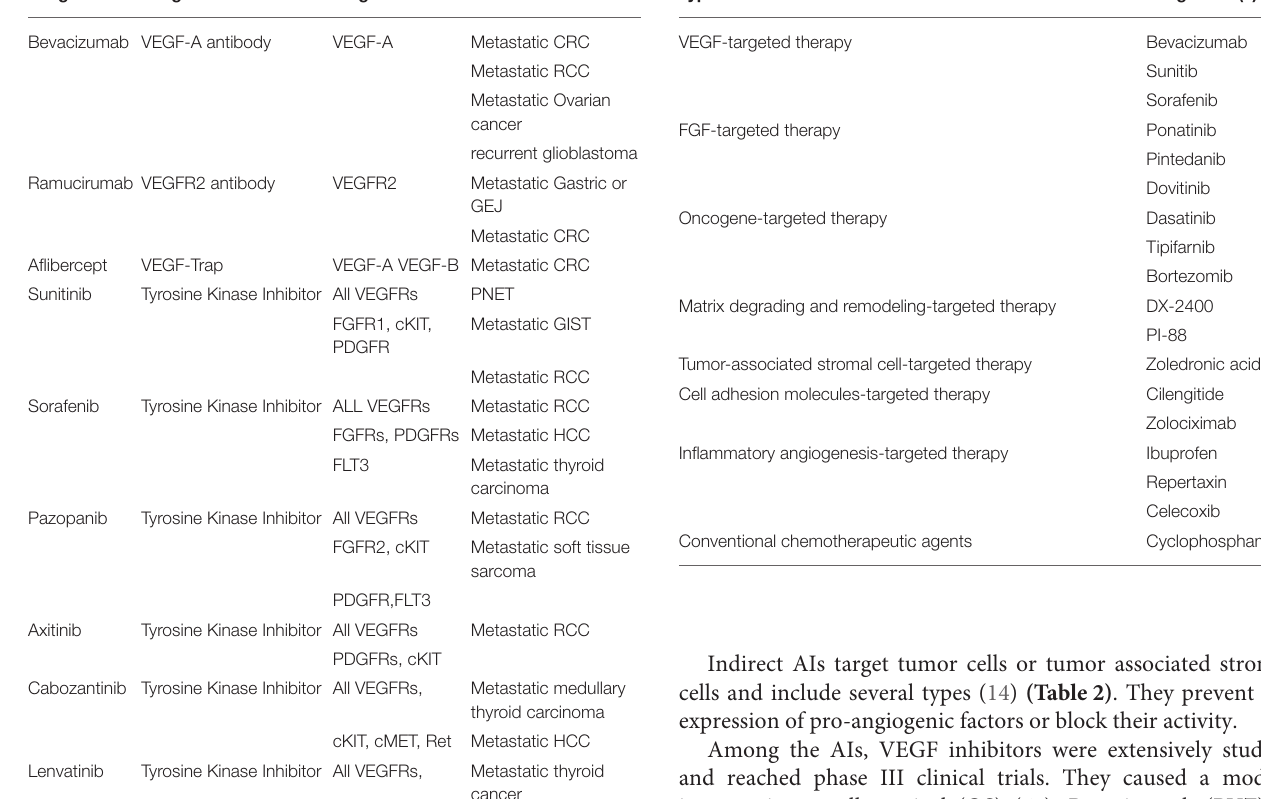
TABLE 1 | List of some FDA-approved anti-angiogenic agents. Drug name Drug class